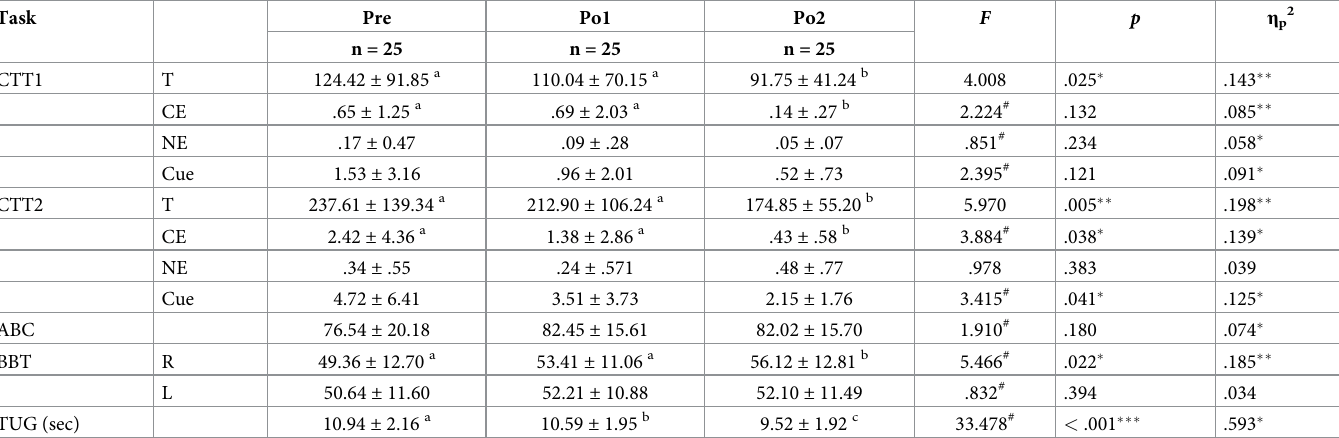
Table 2. Summary of repeated measure analysis of variance in cognition, upper extremity gross motor function, functional mobility and confidence of falls.